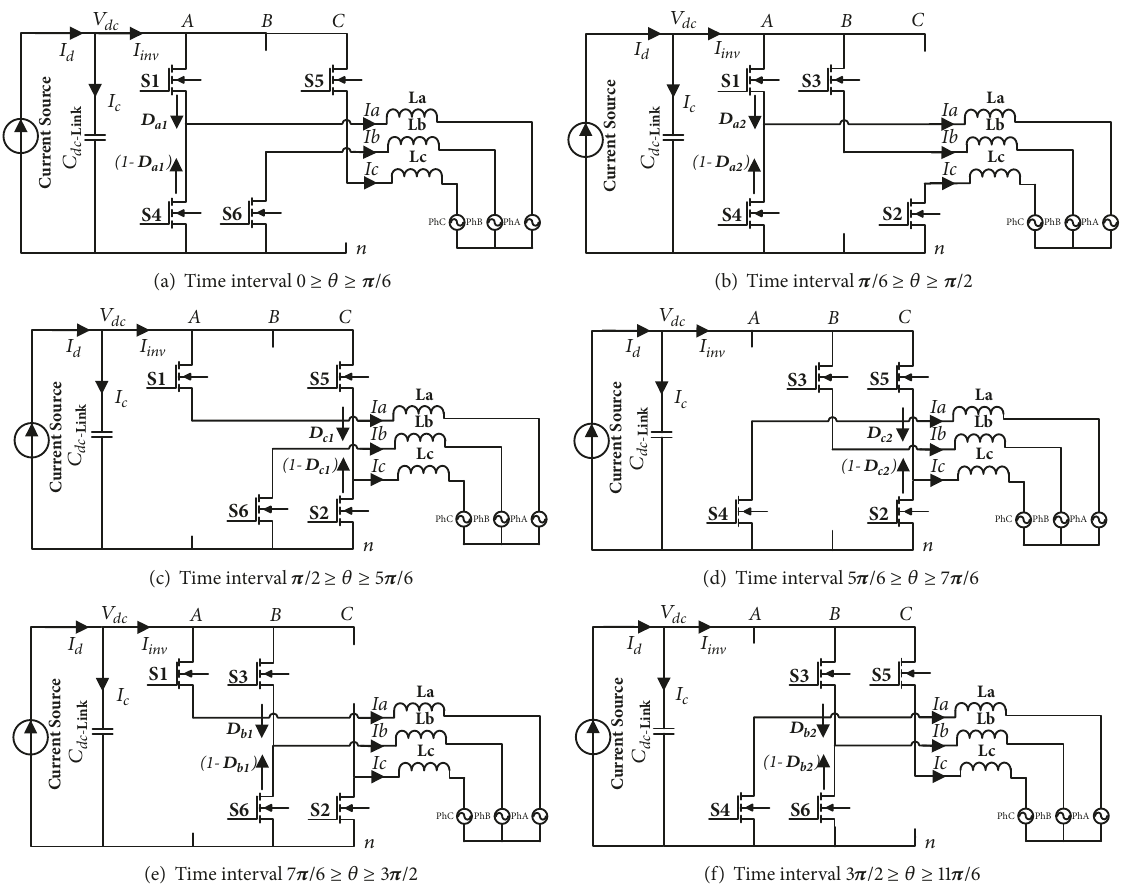
Figure 2: Six switching configurations in 120 ∘ BC-PWM control